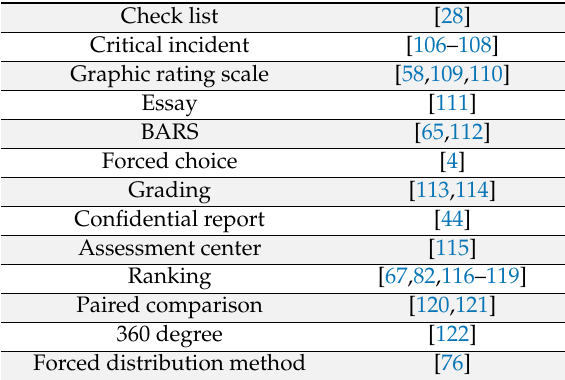
Figure 7. Types and percentages of applied methods for performance evaluation in the collected papers. Table 12. Some adopted methods and corresponding references